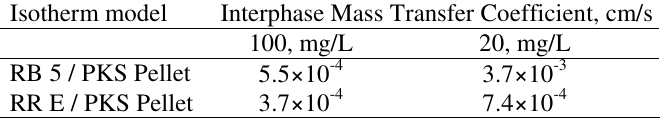
Table 2. External mass transfer coefficient k based AC (single